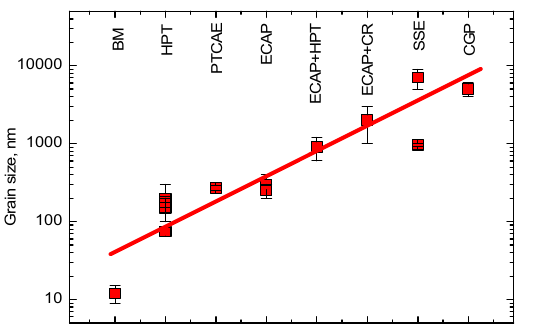
Figure 1. Steady-state grain size in copper subjected to the different SPD modes: 1—Ball milling (BM) [1], 2—HPT [2–7], 3—PTCAE [8], 4—ECAP [4,9], 5—ECAP + HPT [4], 6—ECAP + CR [10], 7—SSE [11,12], 8—CGP [13].